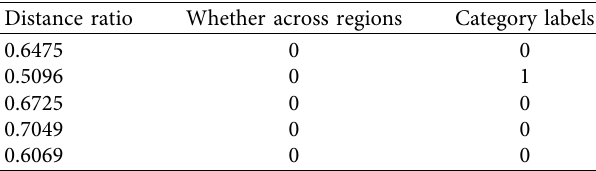
Table 2: Examples of resource impact samples.